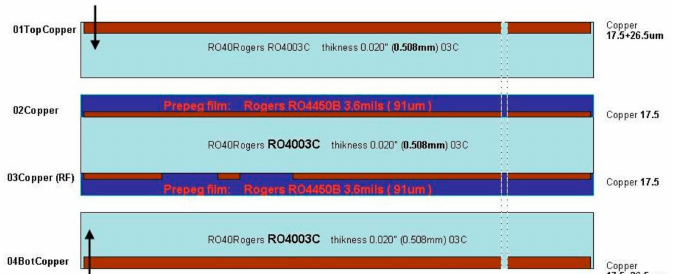
Figure 6. Cross-section of the PCB adopted for the design of the WS RF / IF module, based on a four-layer RG4003C